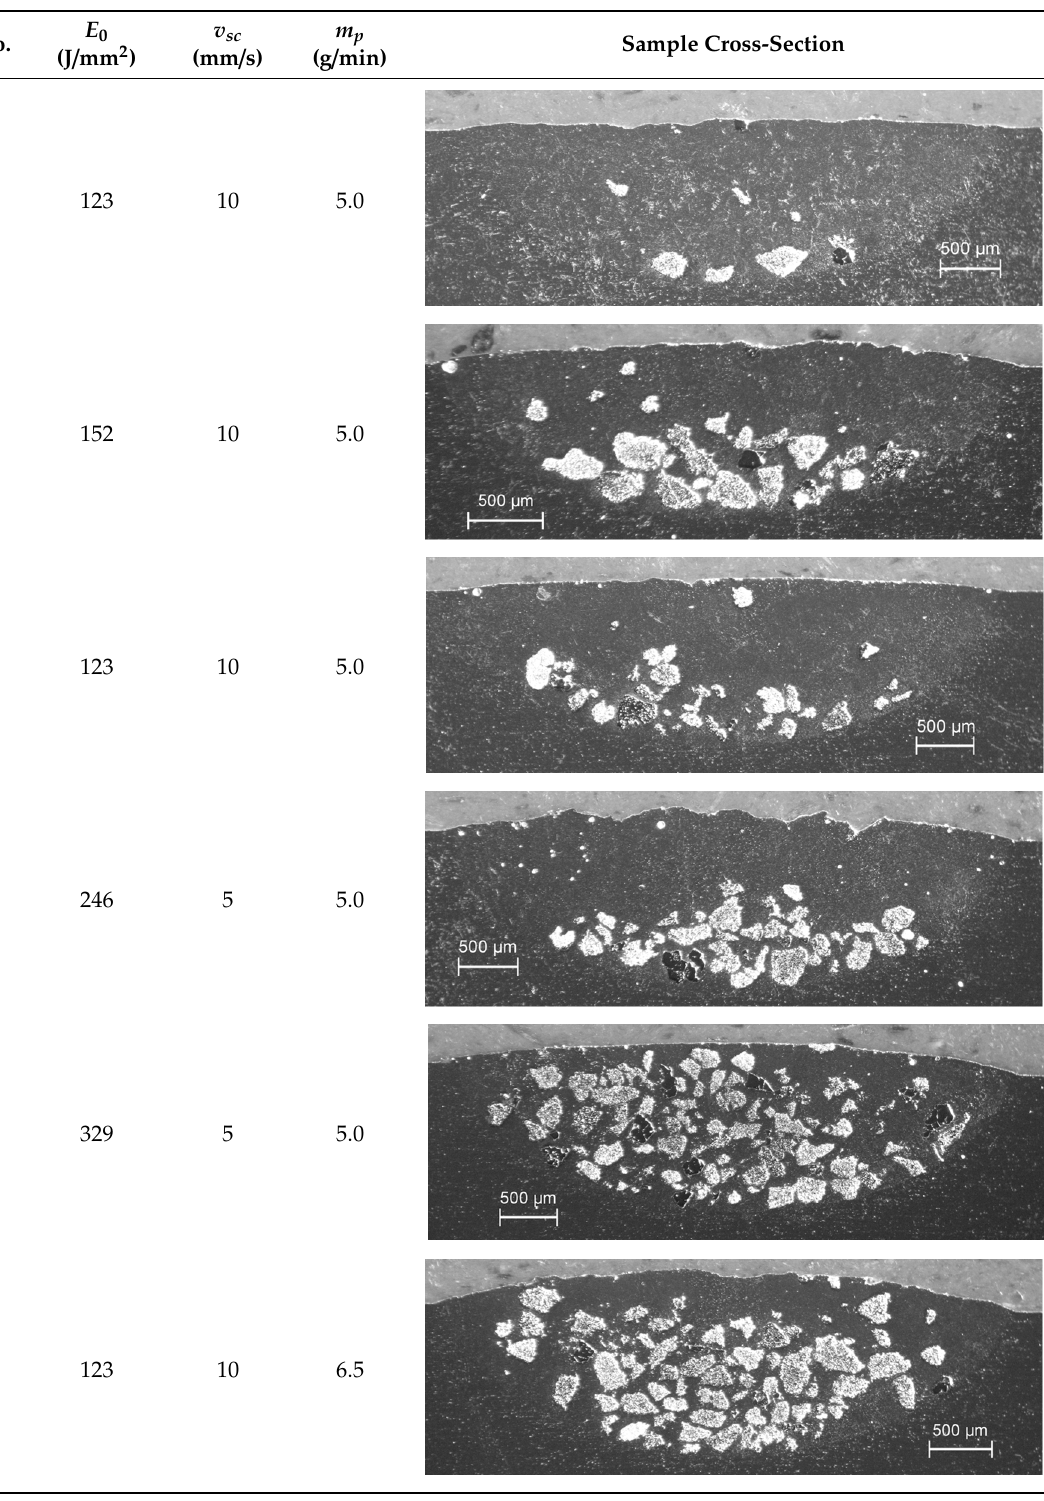
Table 5. Process parameters and microstructures of single MMC traces of laser dispersed TiC particles in Al6061.